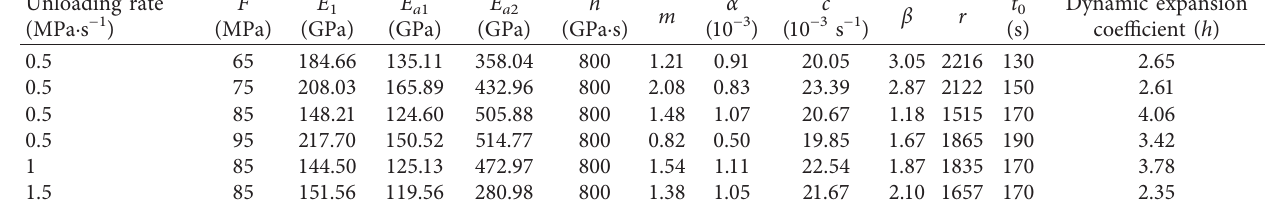
Table 3: The experimental parameters and theoretical fitting parameters.